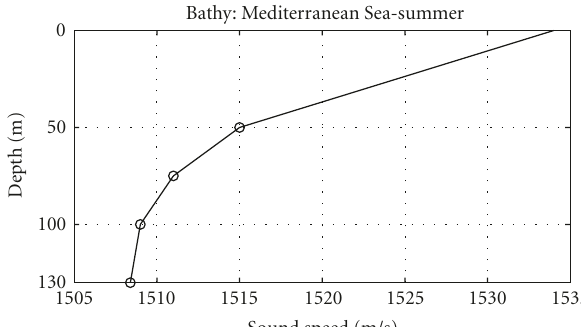
Figure 1: Sound speed profile of the water column for Mediterranean Sea in